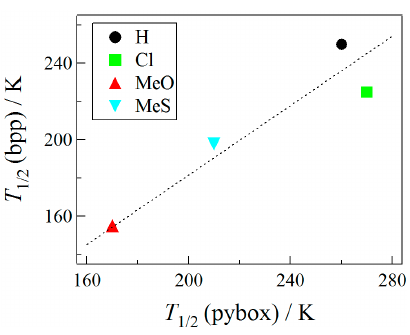
Figure 5. Plot of T 1/2 for solution [Fe(X-1-bpp) 2 ](ClO 4 ) 2 vs. T 1/2 for solution [Fe(X-pybox) 2 ](BF 4 ) 2 . The [Fe(X-1-bpp) 2 ](BF 4 ) 2 data are taken from Ref. [32]. A dotted line represents the best linear